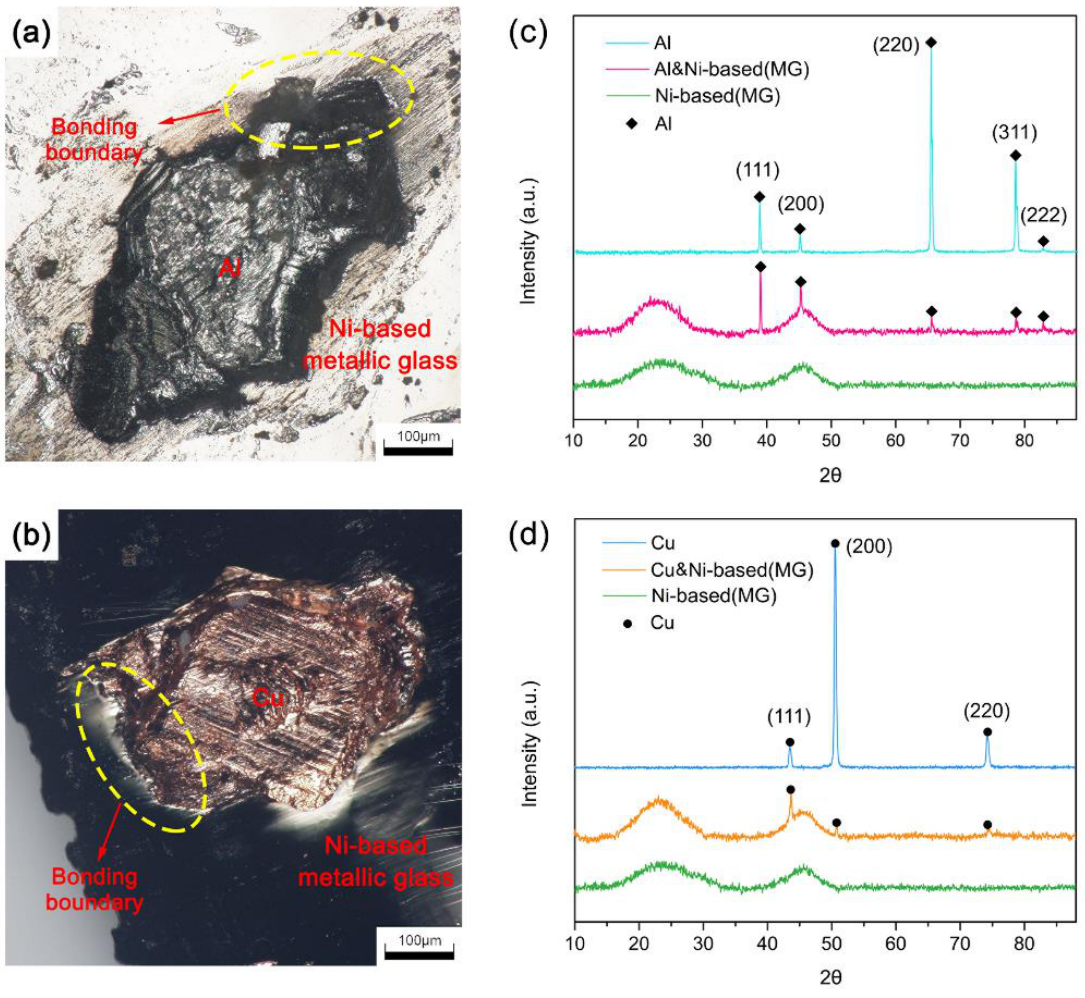
Figure 4. The joint surface morphology ( a ) of the Al / Ni-based (MG) composite sample at a bonding time of 80 ms, and the XRD results ( c ) of the joint surface and relative raw materials. The joint surface morphology ( b ) of the Cu / Ni-based (MG) composite sample at a bonding time of 60 ms, and the XRD results ( d ) of the joint surface and relative raw materials.